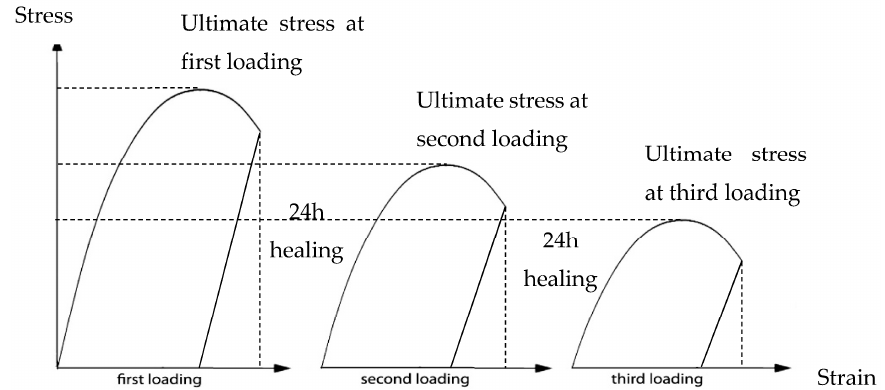
Figure 14. The mechanical response of the pre-cracked concrete beam under three-point-bending.